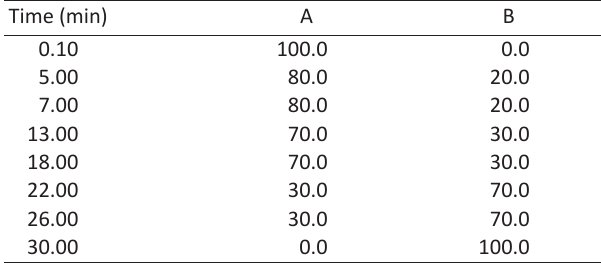
Table 1 - Linear solvent gradient system used in HPLC-DAD and HPLC-MS analysis Time (min)